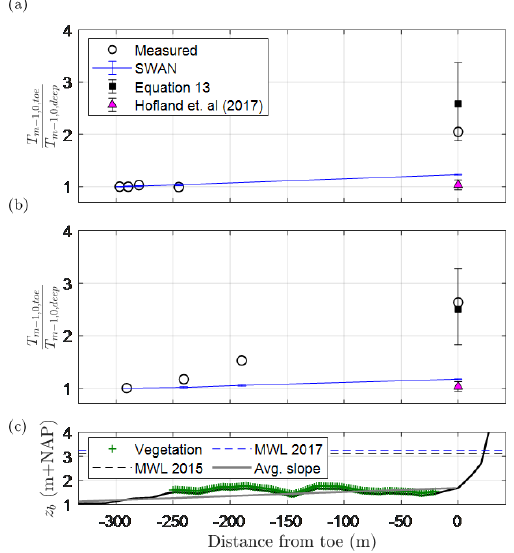
Figure 8. Comparison of measured and modelled relative spectral wave period ( T m − 1 , 0 , toe /T m − 1 , 0 , deep ) at the peaks of the (a) Jan- uary 2015 and (b) January 2017 storms at Uithuizerwad (see Fig. 5 for gauge locations). Error bars represent the uncertainty in the es- timates based on the standard deviations of Eq. (12), Eq. (18) and the Hofland et al. (2017) formula (Appendix C). Panel (c) shows the bed level and vegetated cover. MWL: mean water level (at the peak of the